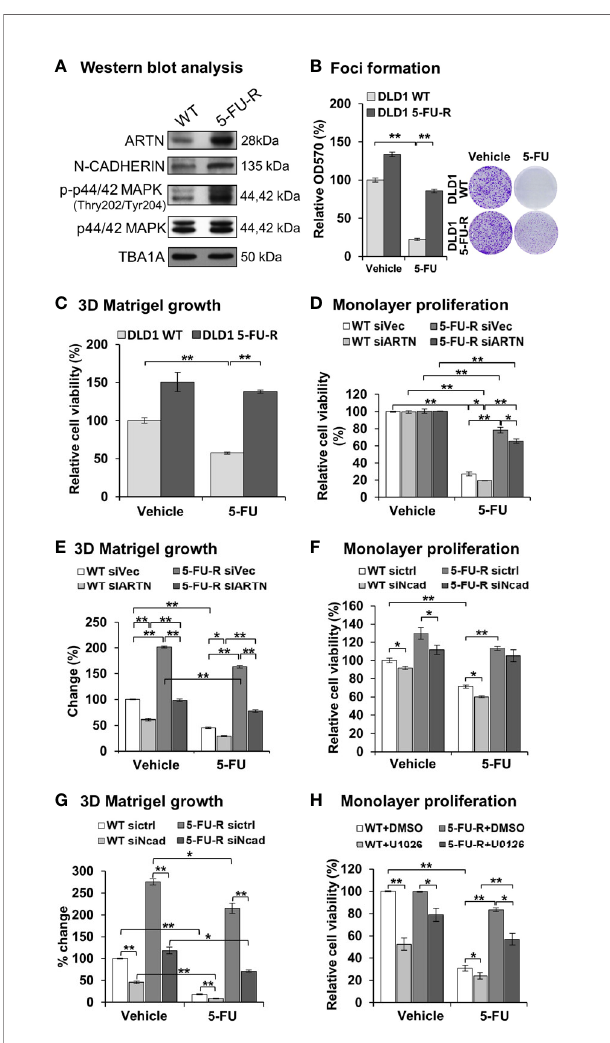
FIGURE 8 | ARTN in CRC cells decreases 5-FU sensitivity and mediates 5-FU resistance. (A) Western blot analysis for the expression of ARTN, CDH2 and p44/42 MAPK in the control (WT) and 5-FU-R cells. (B) Foci formation of 5-FU-R/WT cells in the absence or presence of 3.5µM 5-FU for 7 days. (C) 3D Matrigel growth of 5-FU-R/WT cells in the absence or presence of 3.5µM 5-FU. (D, E) , WT and 5-FU-R cells with transient depletion of ARTN